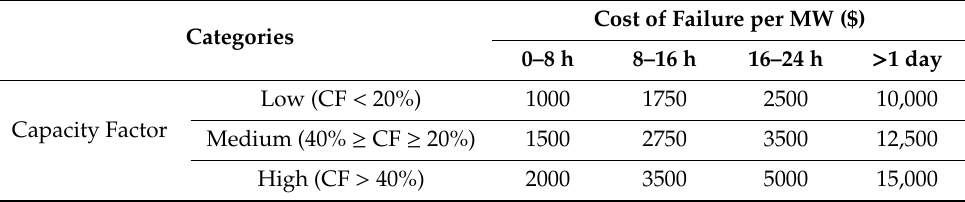
Table 4. Assumed cost of failures in this